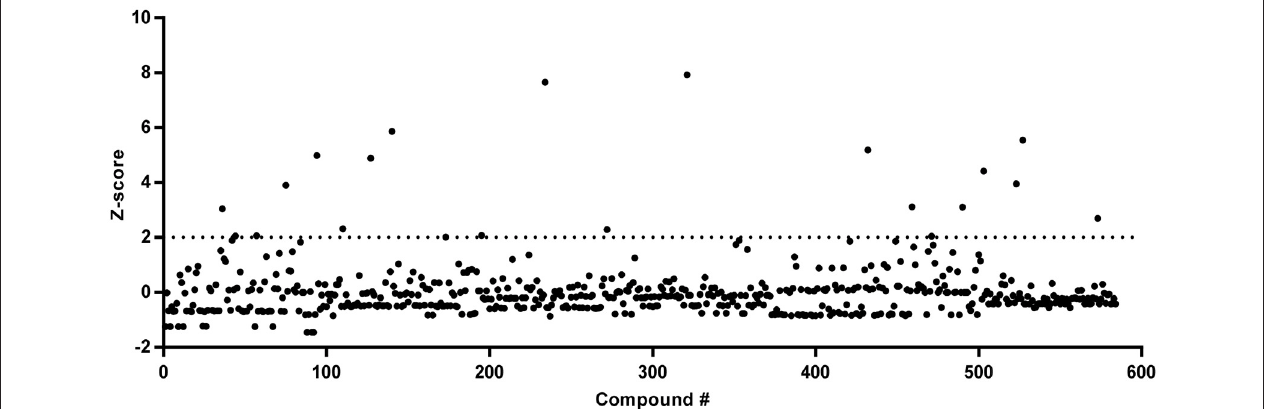
FIGURE 3 | Z-scores of 584 natural products following a primary screening. Stable HTC/ AvBD9 - luc luciferase reporter cells were stimulated with 20 µ g/ml of natural products for 24h in 96-well plates, followed by the luciferase assay. The alamarBlue Dye was added 4h before the luciferase assay to measure cell viability. The luciferase activity of each compound was normalized to cell viability before the Z-score was calculated.